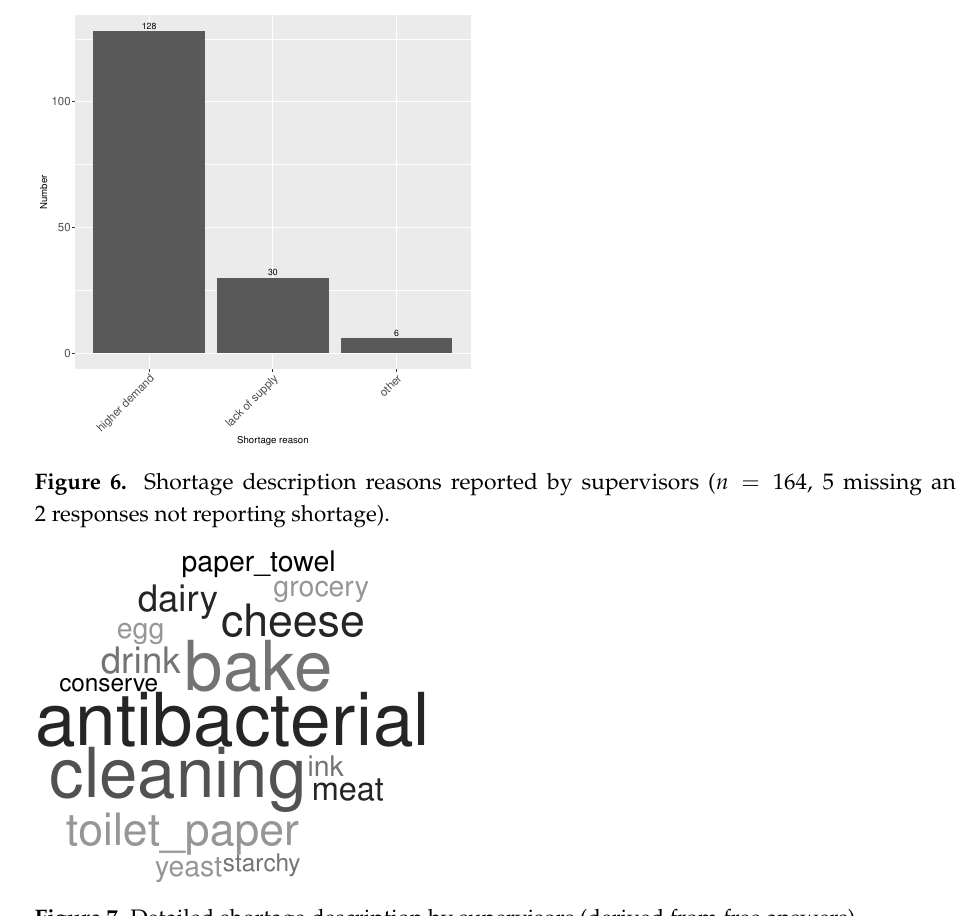
Figure 7. Detailed shortage description by supervisors (derived from free answers). In addition, 35% of supervisors experienced mood change during the lockdown.